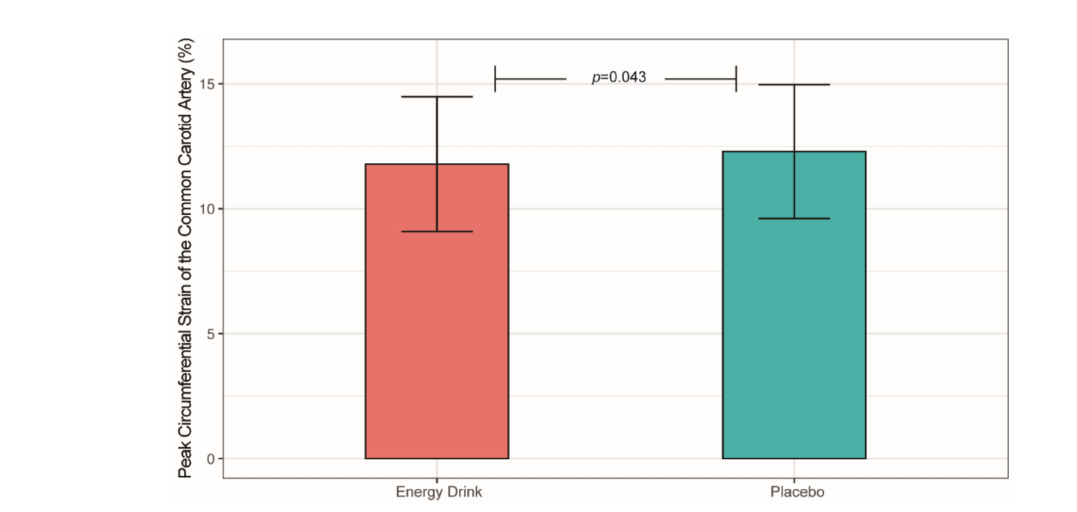
Figure 2. Peak Circumferential Strain (CS, %) of the Common Carotid Artery after Energy Drink and Placebo